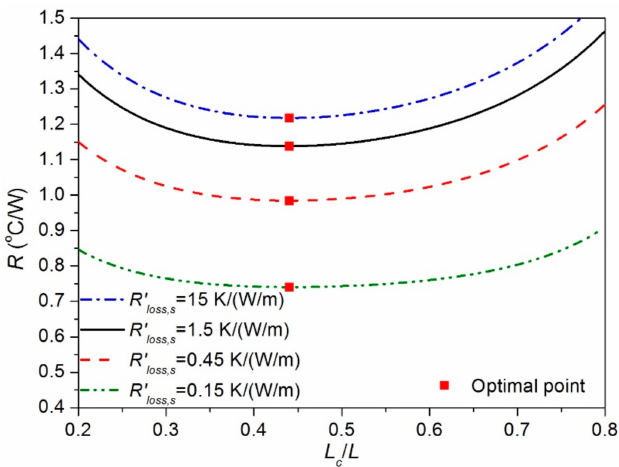
Figure 10. Thermal resistances for various heat losses through the sides of the heat sink ( Q = 0.2 m 3 / min, w c = 7 mm, L h / L = 0.2).